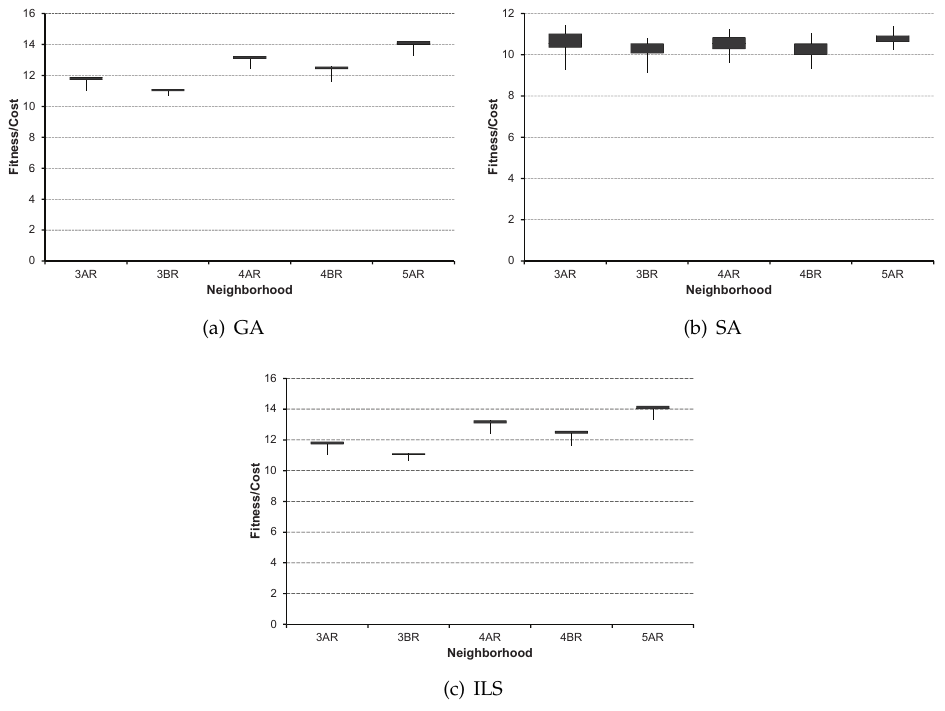
Figure 3. Fitness/cost dispersion vs. Neighborhood when applied to HL subband. ( a ) For GA algorithm. ( b ) For SA algorithm. ( c ) For ILS algorithm.